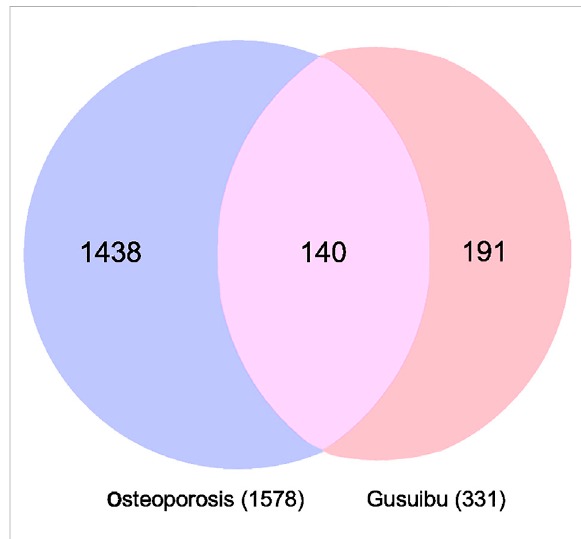
FIGURE 1 Venndiagramfortheintegratedanalysisoftherelatedtargets of Gusuibu and